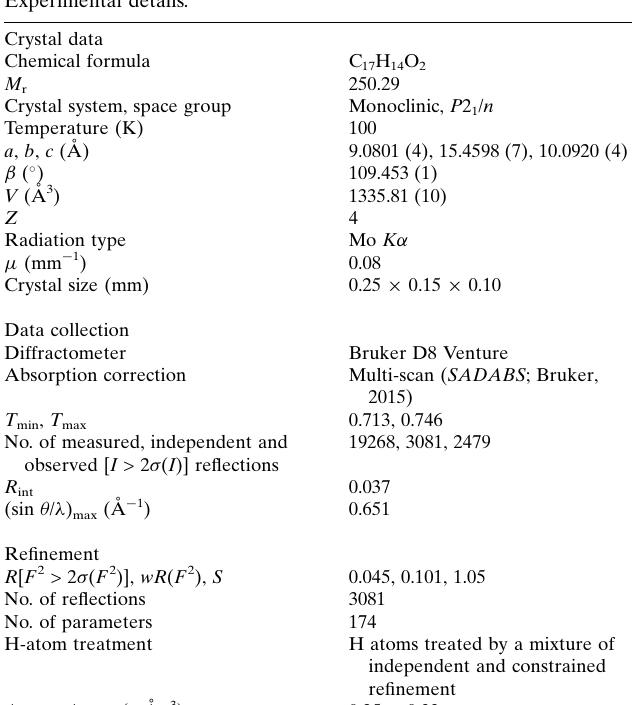
Table 2 Experimental details.